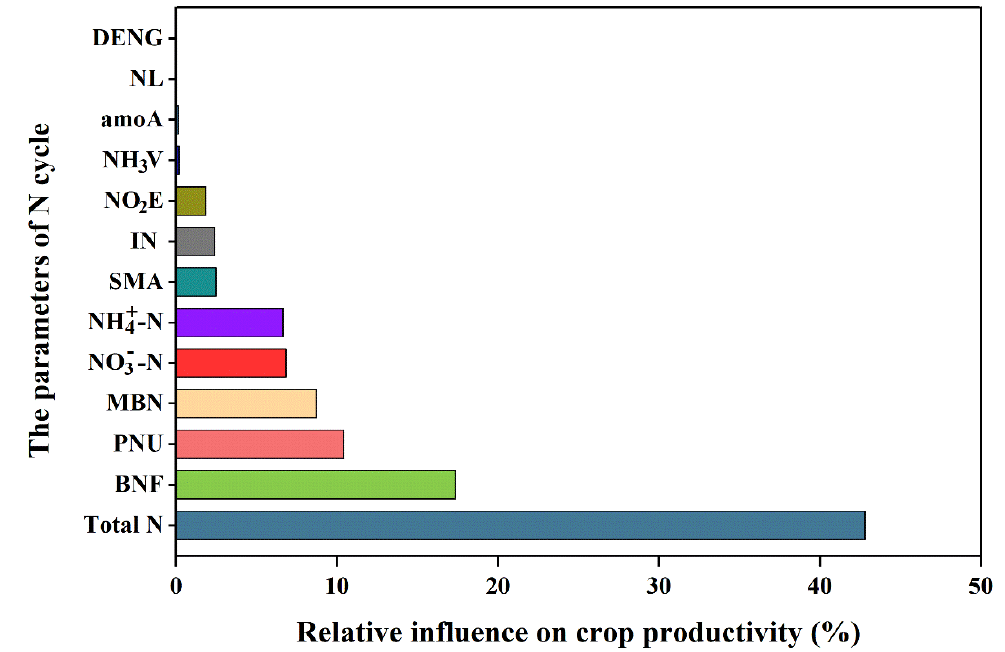
Figure 3. The relative influence (%) of the effects of soil N cycle (microbial biomass N: MBN; inor- ganic N: IN; ammonium N: NH 4+ -N; nitrate N: NO 3 − -N; NH 3 volatilization: NH 3 V; N 2 O emission: